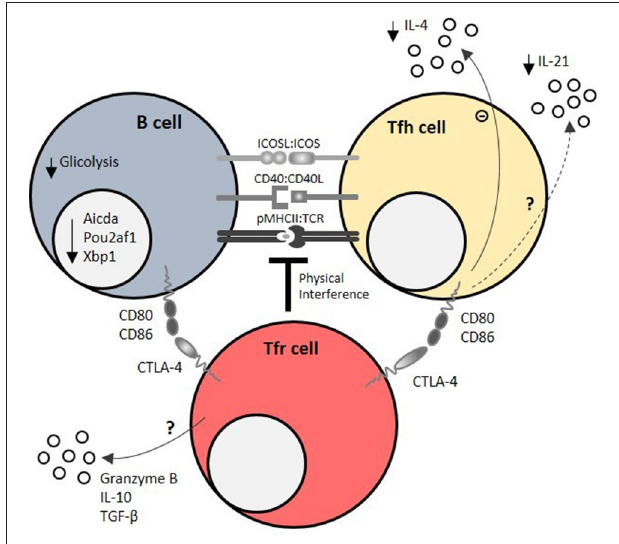
FIGURE 3 | Mechanisms of Tfr cell-mediated regulation of humoral responses. Tfr cells regulate T – B interactions within the germinal center (GC) by physical interference at the immunological synapse, which is required for the survival feedback loop between GC B cells and T follicular helper (Tfh) cells. CTLA-4 is a key molecule of T follicular regulatory (Tfr) cell function at immunological synapse, as it directly blocks CD80/CD86 co-stimulatory signals. Using these mechanisms, Tfr cells impair GC B cell metabolism (mainly by decreasing glucose uptake and usage) and induce the downregulation of GC B cell effector molecules, such as Pou2af1 (required for GC B cell formation), Xbp1 (required for antibody secretion), and Aicda (required for class switch recombination). On the other side of the immunological synapse, Tfr cells limit IL-21, and IL-4 secretion by Tfh cells. Granzyme B, IL-10 and TGF- β secretion by Tfr cells may also account for their regulatory